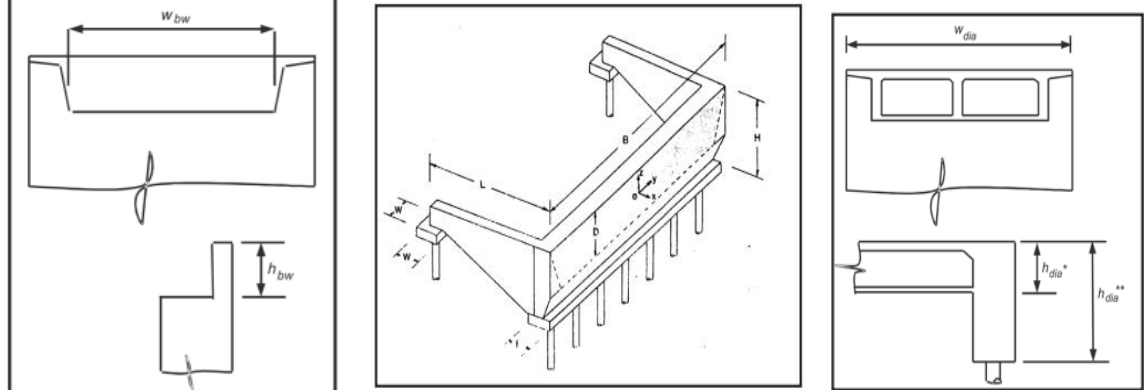
Fig. 4. (a) The specifications and dimensions of the abutment [15], (B and C) How to connect the abutment to the deck [11]. (A) The components of the abutment (middle). (B) A continuous abutment with a deck (right). (C) Non- continuous abutment with deck